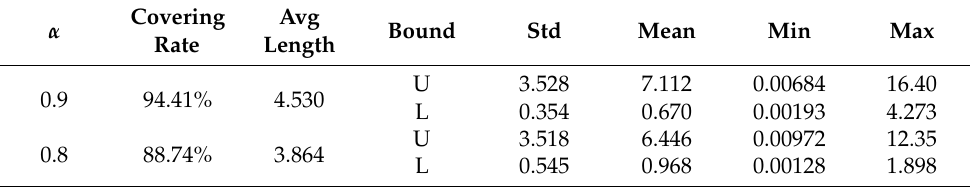
Table 4. Statistics of interval estimation for surface concentration (unit: µ g/m 3 ).